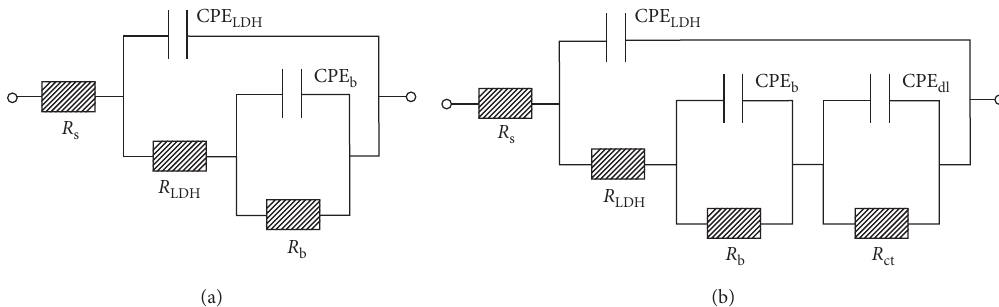
Figure 10: Electrical equivalent circuits employed to fit the EIS experimental dataset: (a) at the early stage of immersion (1–120h) and (b) for prolonged immersion (168–1200h) in 0.1M